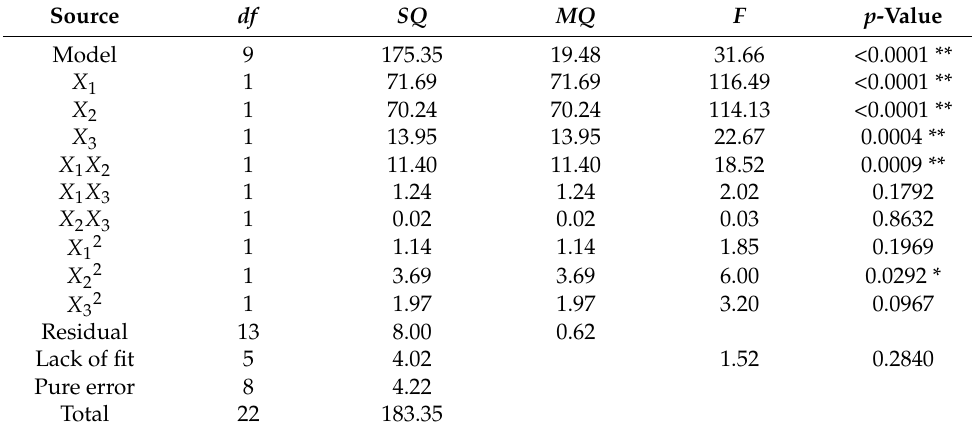
Table 5. Variance analysis of regression